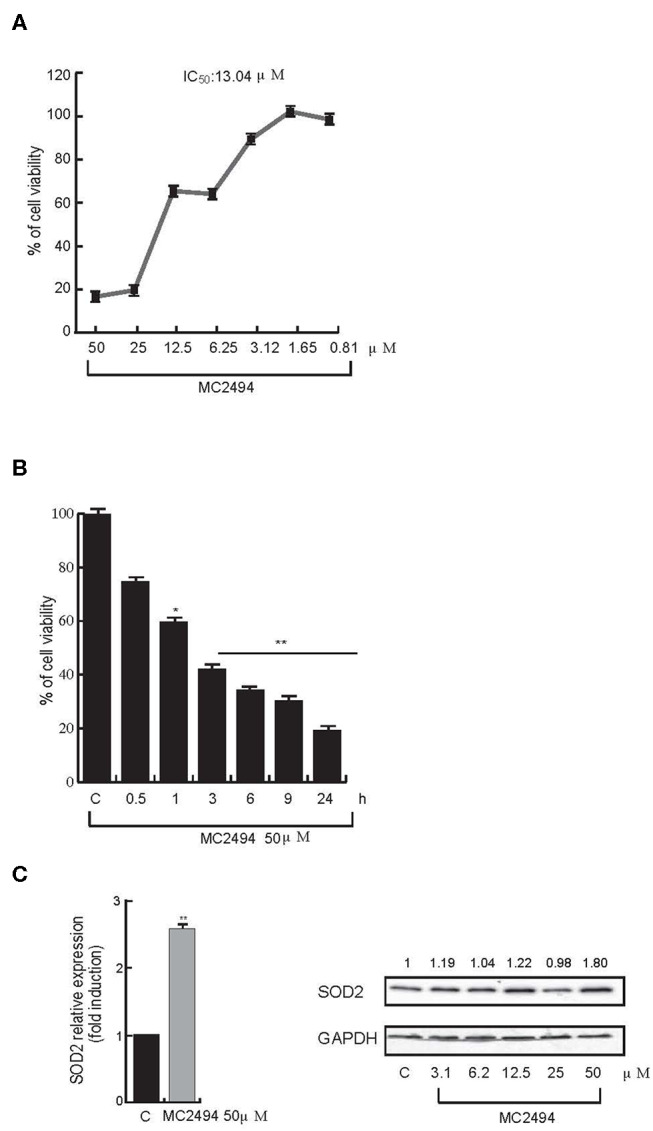
(A) Cell proliferation rate MTT assay. U937 cells were treated at indicated concentrations. IC50 value was calculated by GraphPad Prism 7. (B) Cell proliferation rate WST-1 assay. U937 cells were treated at 50 μM concentration for indicated times. (C) mRNA evaluation of SOD2 (Left panel) and western blot analysis for SOD2 (Right panel). U937 cells were treated with MC2494 for 24 h at the indicated concentrations. Numbers on Western blot indicate the results of densitometry analysis, performed using the Image J Gel Analysis tool. RT-PCR graphs show the mean of at least two independent experiments with error bars indicating standard deviation. Values are mean ± standard deviation (SD) of biological triplicates. **p ≤ 0.01, *p ≤ 0.05 vs. control cells.